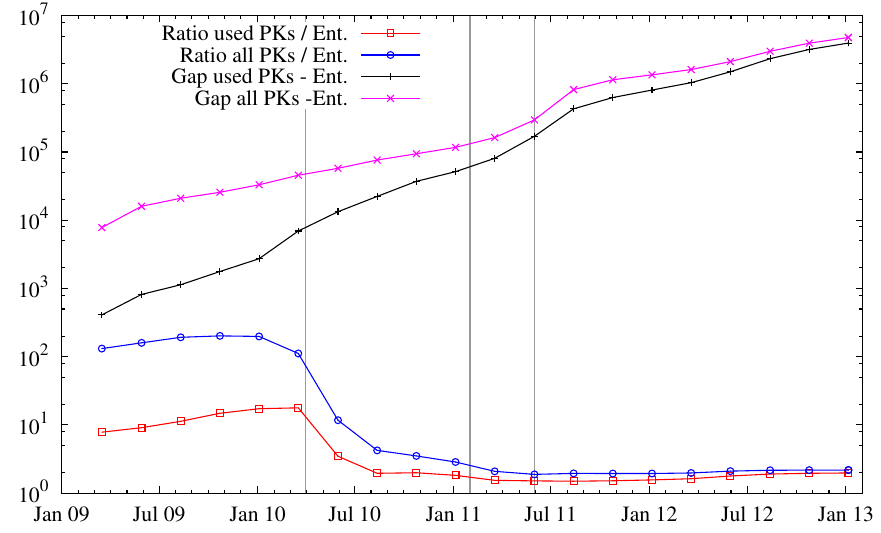
Figure 2. Gap (difference) and ratio between known public keys and entities. See Figure 1 for the vertical